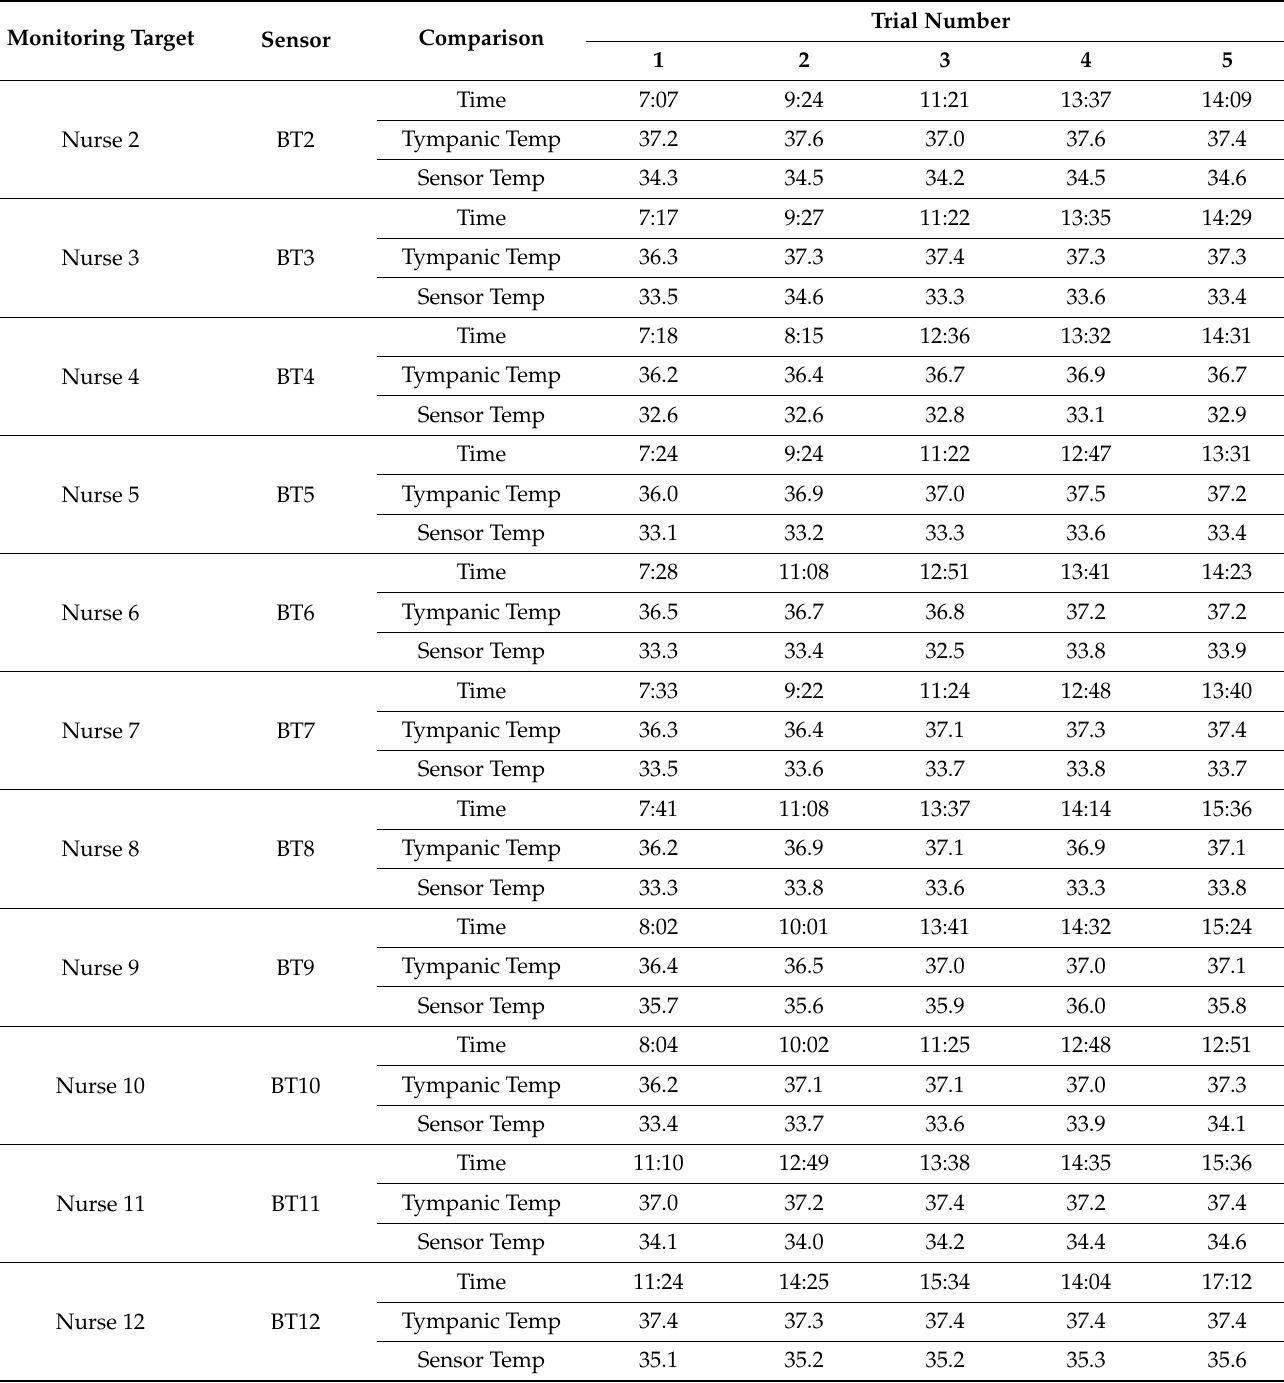
Table 10 summarizes the results of the data collection of location tracking according to the three network methods, which suggests the difference between three network methods range from 14.1% to 10.76% compared to